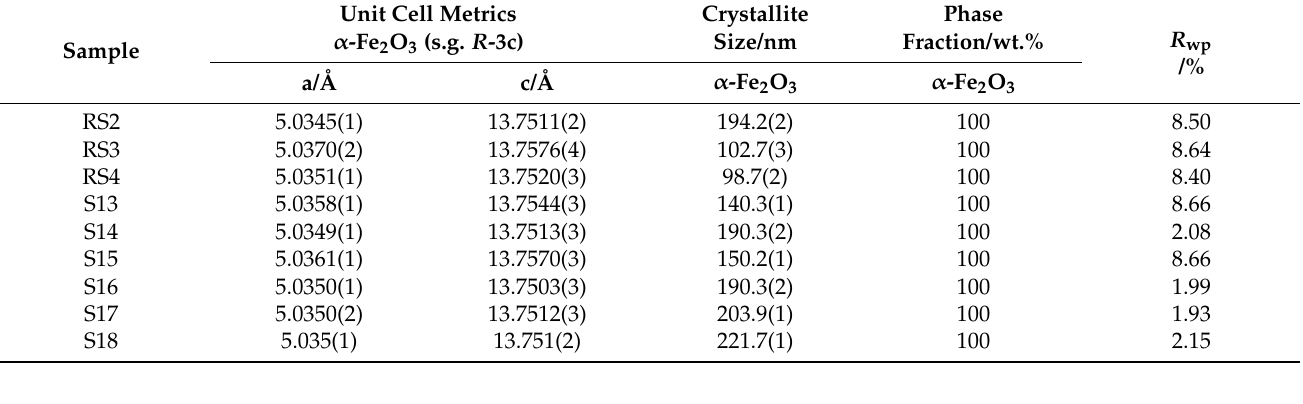
Table 4. The notation of samples prepared at 260 °C with varying synthesis times, results of phase analysis, and resulting microstructural parameters obtained from the Rietveld refinements against laboratory PXRD data.